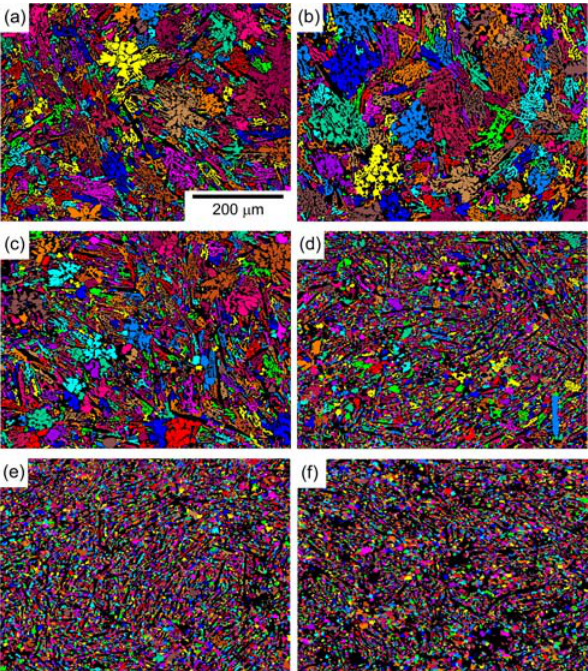
Figure 3: Grain color maps of Mo ss in the MoSiBTiC alloy crept at 1,500°C and 137 MPa with creep stains of ( a ) 0%, ( b ) 3%, ( c ) 12%, ( d ) 32%, ( e ) 53%, and ( f ) 72%.